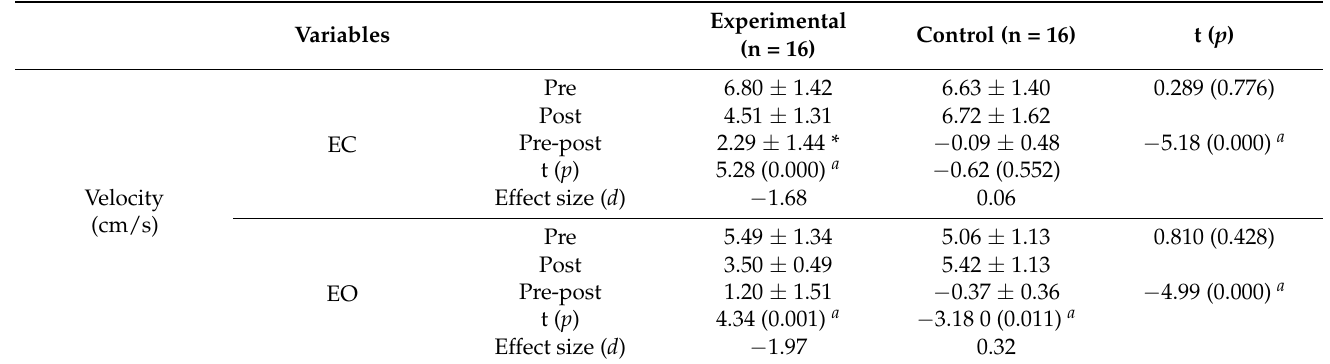
Table 6. Comparison of Static balance test within and between